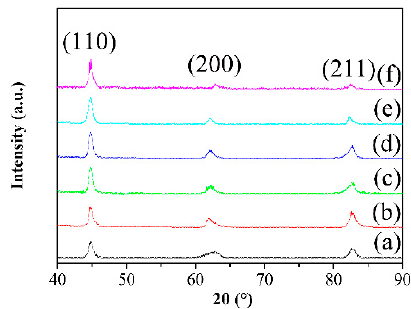
Figure 1. XRD patterns of Fe films prepared at different sputtering powers: ( a ) 160 W, ( b ) 230 W, ( c ) 260 W, ( d ) 283 W, ( e ) 360 W, and ( f ) 420 W.